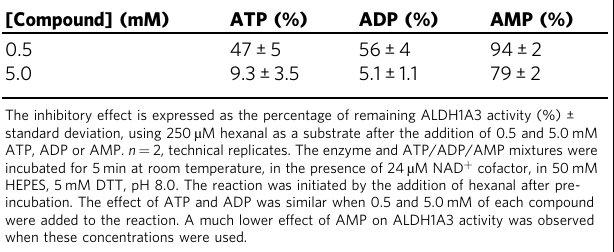
Table 3 Inhibitory effect of ATP, ADP or AMP on the ALDH1A3 activity measured with